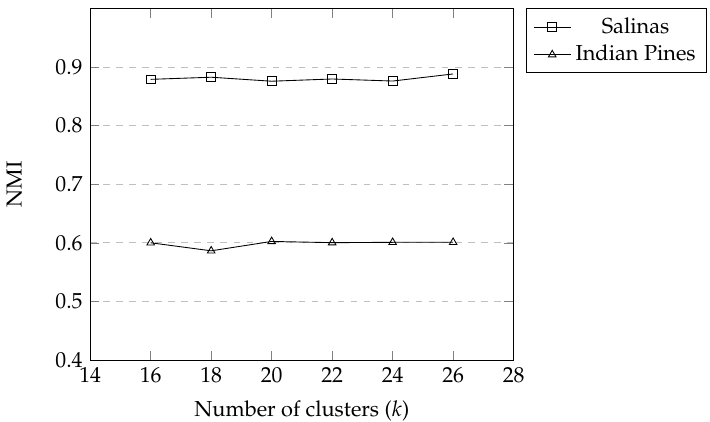
Figure 7. NMI values obtained at different number of clusters for the proposed method, for Salinas and Indian Pines